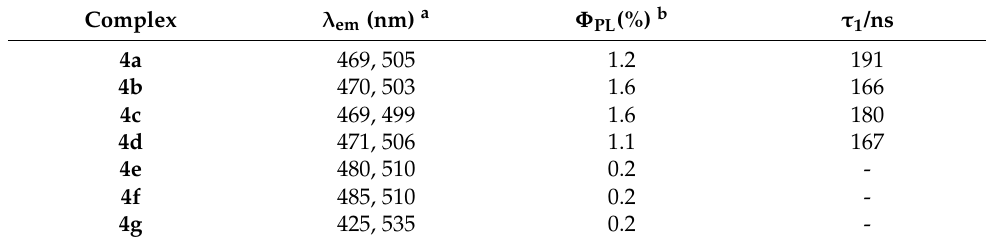
Table 1. Photophysical data of iridium complexes 4a – 4g .